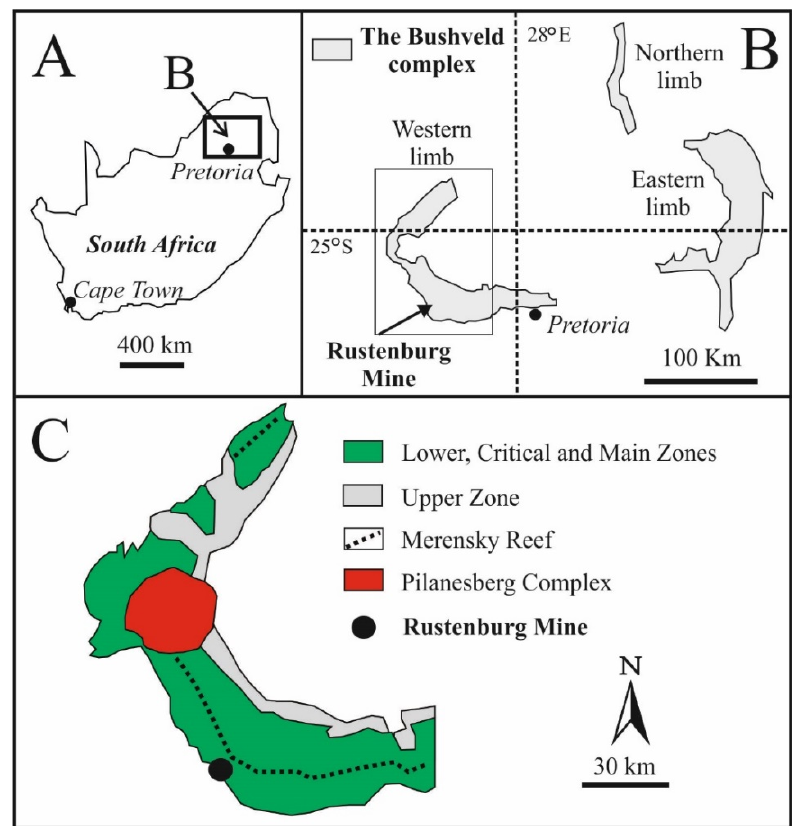
Figure 1. The Bushveld Complex, South Africa ( A ) and locations of the Rustenburg mine and the Merensky Reef ( B and C ) in the Western limb (modified after [15,18]).